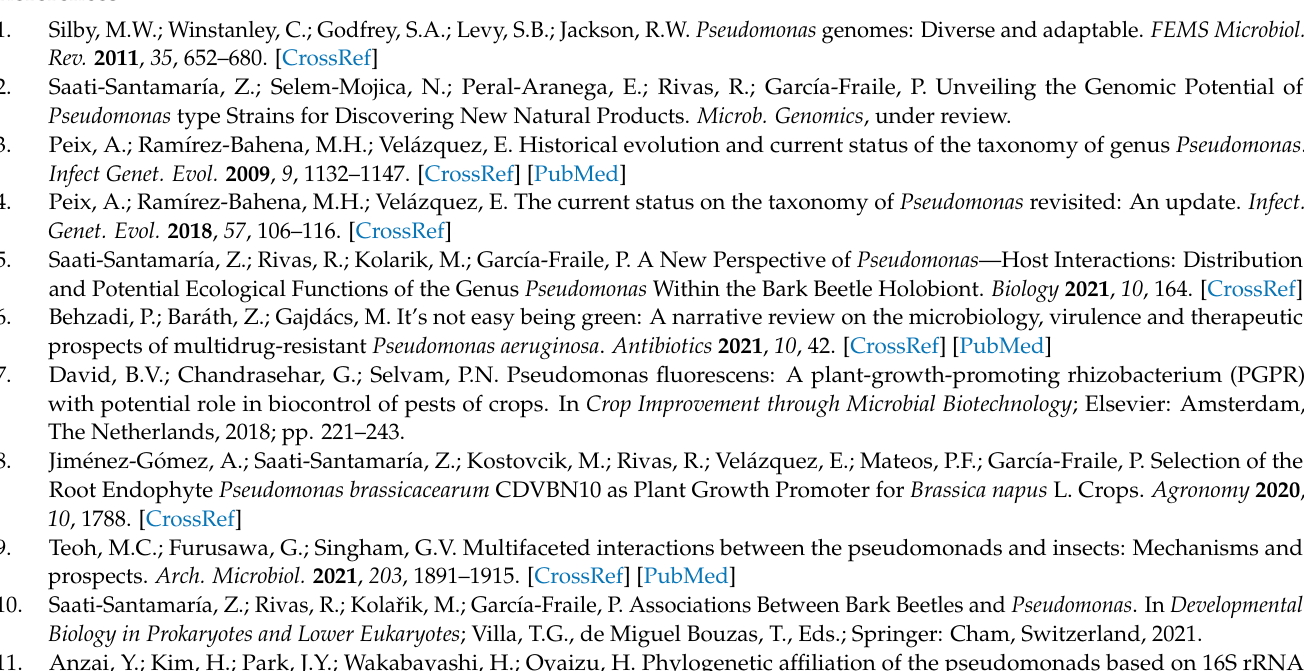
Table S2: ANIb values shared among Pseudomonas type strains that are proposed as novel genera and representative type strains belonging to different Pseudomonas and Pseudomonadaceae clades, Table S3: Table S4: Digital DNA-DNA Hybridization (dDDH) values of different type strains that are studied for its taxonomic relocation. Table S5: ANIb values shared among different Xanthomonas type strains and P. cissicola CCUG 18839 T . Table S6: AAIb values shared among Pseudomonas type strains that are proposed as novel genera and representative type strains belonging to different Pseudomonas and Pseudomonadaceae